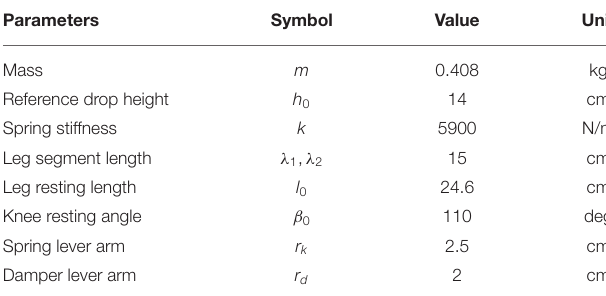
TABLE 1 | Simulation and hardware parameters.